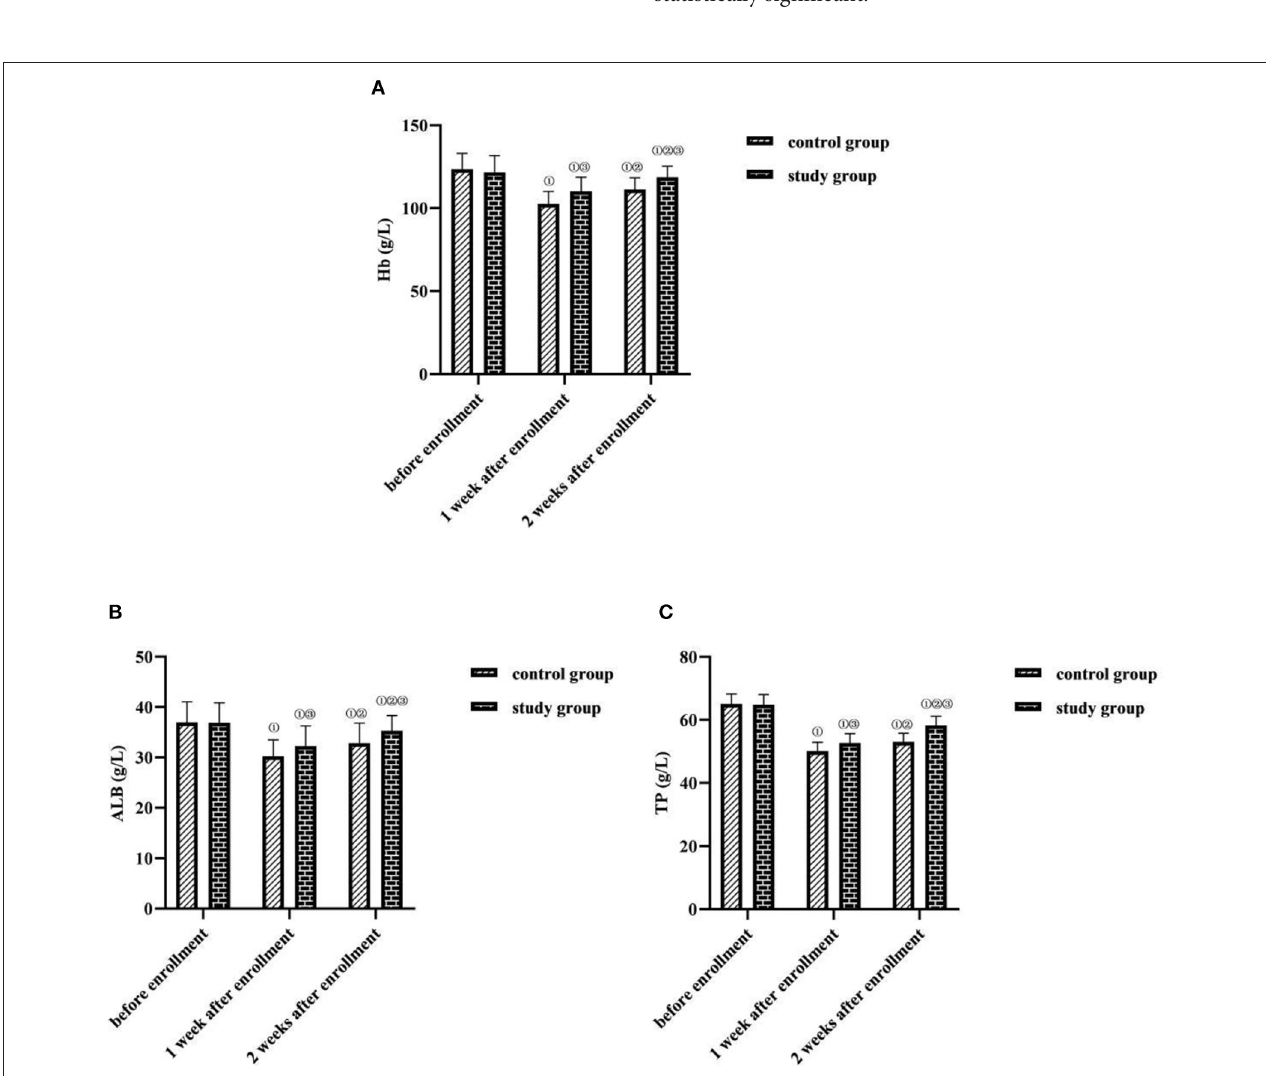
FIGURE 1 | Comparison of serum nutritional index levels between the two groups ( M ± SD , g/L). (A) Hb levels (g/L). (B) ALB levels (g/L). (C) TP levels (g/L). ‹ P < Compared with the same group before enrollment, 0.05; compared with the same group at 1 week after enrollment, fi P < at the same time point,